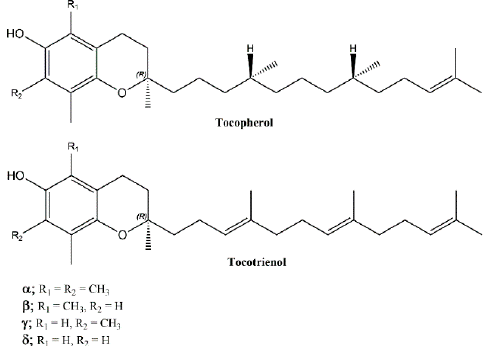
Figure 1. Chemical structures of the Vitamin E analogues.